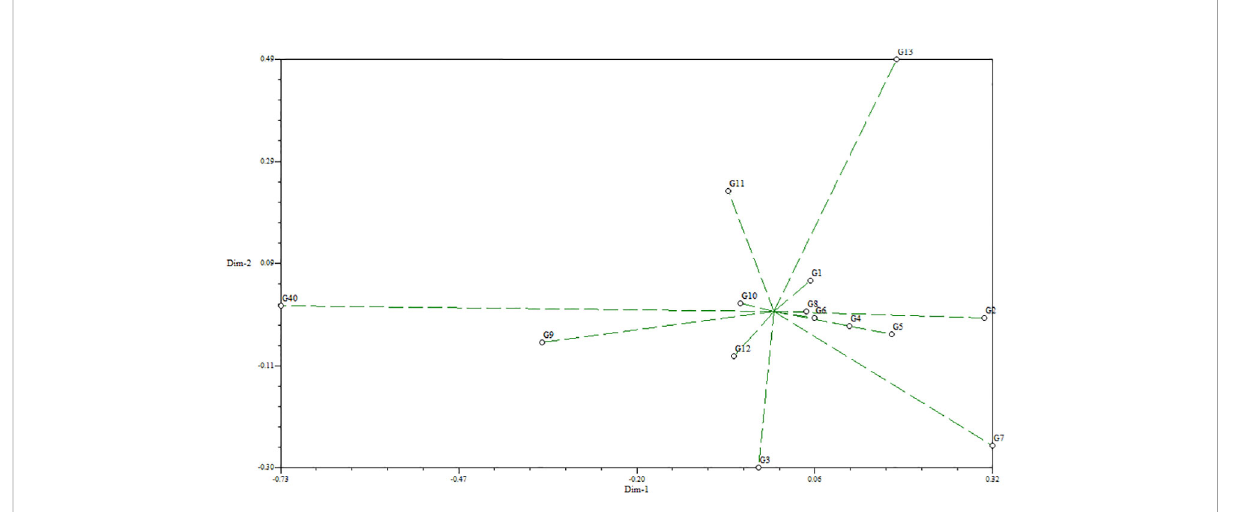
FIGURE 4 Principal component analysis for the MR219-based population.